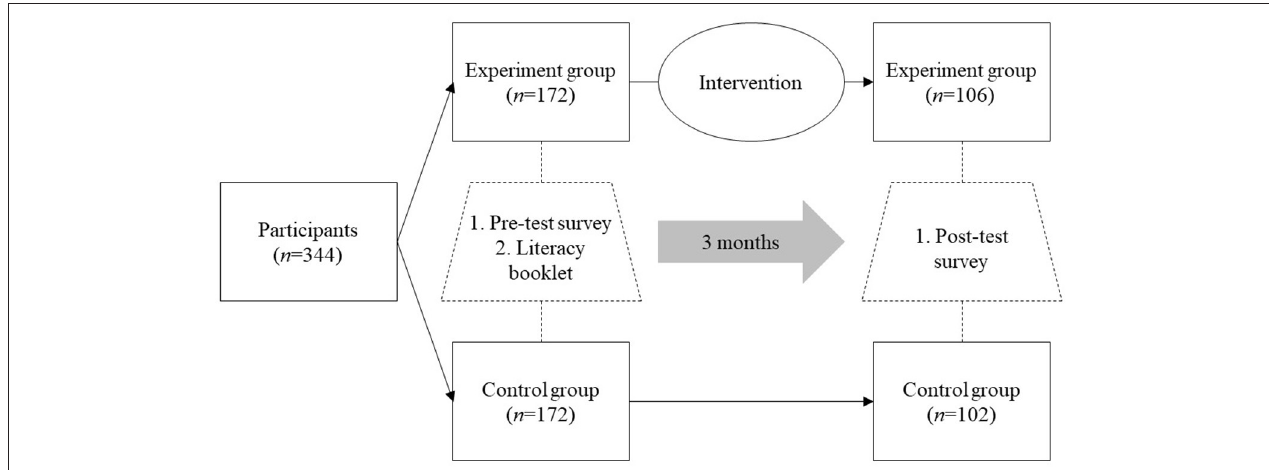
FIGURE 1 | Flow of participants in the